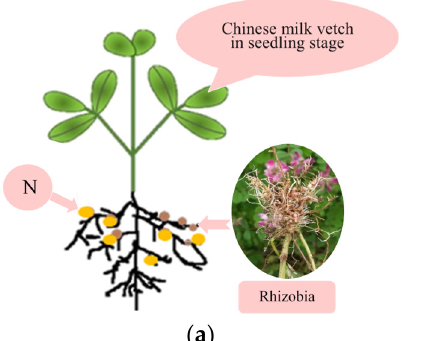
Figure 1. Growth states of Chinese milk vetch at different periods. ( a ) Nitrogen-fixation effect pic- ture of Chinese milk vetch in seedling stage. ( b ) Chinese milk vetch during harvest.